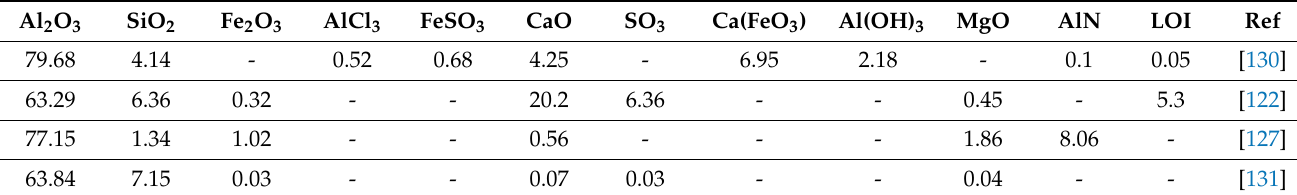
Table 8. Chemical composition of